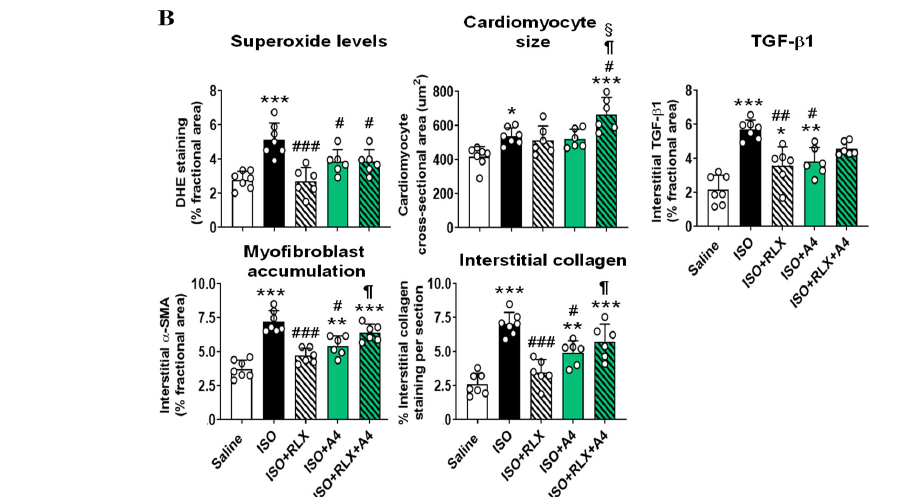
Figure 6. The effects of ISO as well as RLX and/or A4 treatment on measures of LV oxidative stress, cardiomyocyte hypertrophy and fibrosis. ( A ) Representative immunofluorescent-stained images of LV DHE-stained superoxide levels (red staining), cardiomyocyte size and interstitial TGF- β 1 (red staining, counterstained with DAPI (blue) staining of cell nuclei) α -SMA (red staining, counterstained with DAPI (blue) staining of cell nuclei) and interstitial collagen deposition (red-staining) from saline (SAL)- or ISO-injected mice at day 14, and from ISO-injured mice that were treated with RLX (R), A4 or R+A4 from days 7–14 post-injury. Scale bar = 50 µm or 2 mm for the picrosirius red-stained LV sections. ( B ) Also shown is the mean ± SEM % fractional area of each of the end points measured, from n = 6 non-overlapping fields per section or >100 cardiomyocytes per section and n = 6–7 mice per group. The individual data sets for each group are represented by the white circles within each set of bar graphs. * p < 0.05, ** p < 0.01, *** p < 0.001 compared to the SAL group; # p < 0.05, ## p < 0.01, ### p < 0.001 compared to the ISO group; ¶ p < 0.05 compared to the ISO+RLX-treated group; § p < 0.05 compared to the ISO+A4-treated group.